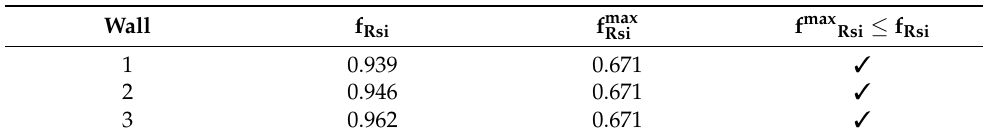
Table 5. Surface condensation: inspection of the thermo-hygrometric behaviour of the examined walls.